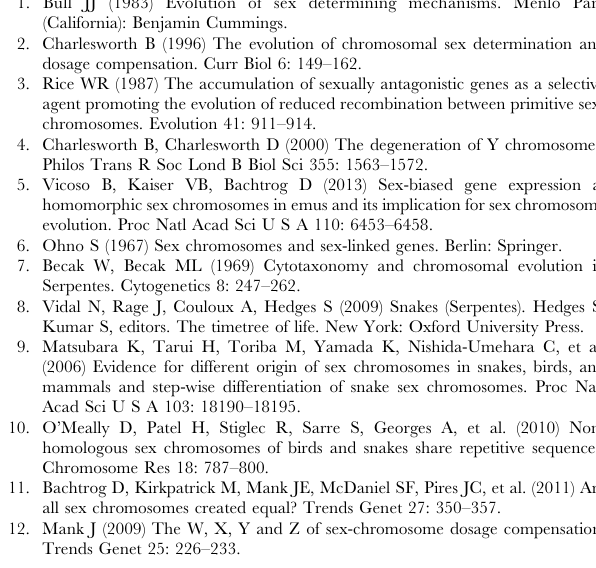
(from the same samples used for the genomic sequencing), and an annealing temperature of 58 u C. W-linkage was confirmed by the appearance of female-specific bands. Figure S12 Log 2 of expression in female and male, and log 2 of female over male expression, for the different macrochromosomes of pygmy rattlesnake using differ- ent cutoff values. Only genes with FPKM values over 0 (upper panel), 1 (middle panel), or 10 (lower panel) were used in the analysis. Figure S13 Synteny of genes between Anolis chromo- somes and the eight largest boa scaffolds that mapped to macrochromosomes. Anolis CDS sequences were mapped to the boa genomic scaffolds using blat. The corresponding location of each gene on the eight largest scaffolds that mapped to Anolis macrochromosomes was plotted against their location on the corresponding Anolis chromosome. Figure S14 Location of all 431 Z-linked pygmy rattle- snake transcripts (grey) and of the 80 genes with log 2 (F/ M expression) = 0 ± 0.3 (red, corresponds approximately to 0.8 , F/M , 1.2) along chromosome 6 (Z). Table S1 Assembly statistics for boa, pygmy rattle- snake, and garter snake genomes. Table S2 Mapping of known Z-linked and autosomal markers of rat snake to the Anolis genome. Table S3 Average pairwise synonymous and non-syn- onymous divergence between all the species used in this study. Table S4 Divergence at synonymous and nonsynon- ymous sites between Z-W gametologs.